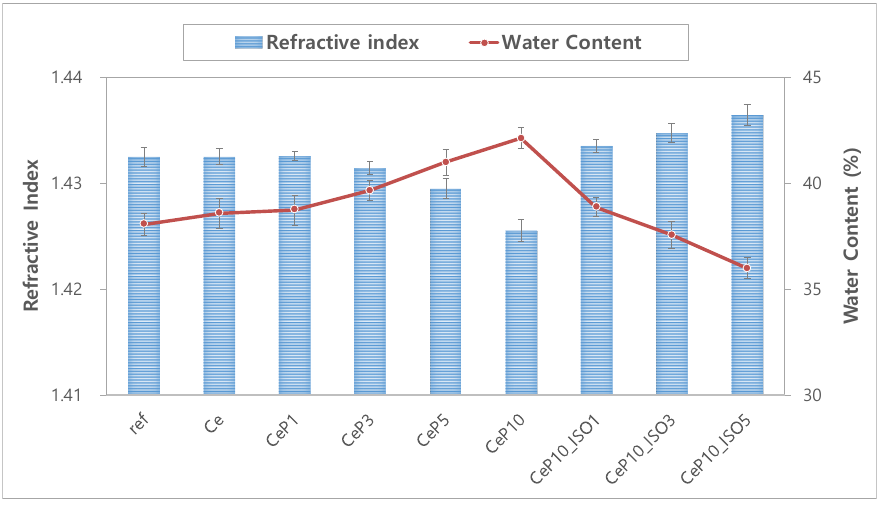
Figure 1. Change in refractive index and water content of samples.